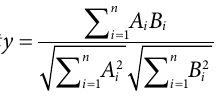
FIgUrE 8 | Rarefaction analysis. (A) Individual-based rarefaction with different sample sizes. Individual-based rarefaction plots were computed with VDJtools using unique sequences (no copy number cut-off) and subsampling to impute expected clone numbers. (B) Rarefaction analysis at different clone size cut-offs in D207. The expected number of clones in the population is given on the y -axis and the number of samples (replicates) is shown on the x -axis. Each line depicts rarefaction curves for clones with a given size cut-off. Clone size C is measured in instances (see